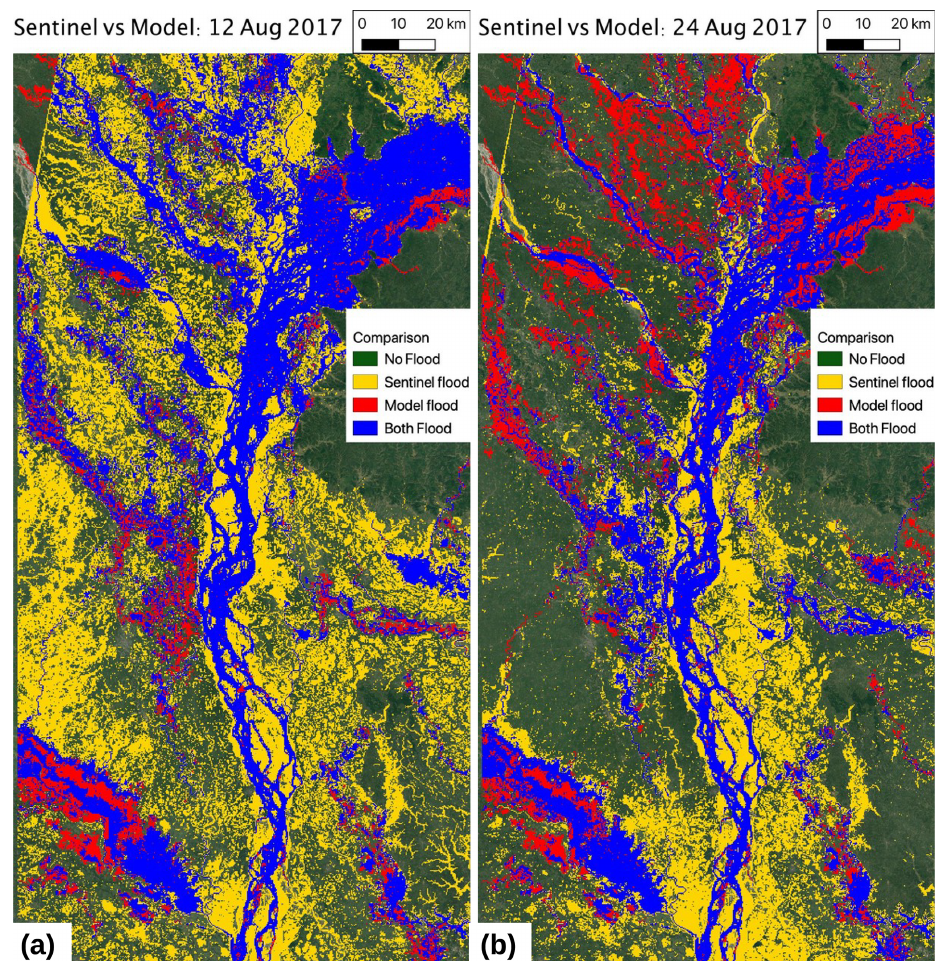
Figure 12. Flood extent comparisons between model and Sentinel observations for the August 2017 flood event. (a) Sentinel image for 12 August 2017. (b) Sentinel image for 24 August 2017. Both panels are compared against the maximum extent of flood inundation greater than 0.5m in a single simulation for 2017. The 270m grid cells for Sentinel are considered flooded where 10% of the higher-resolution cells are flooded. Map data ©Google Earth